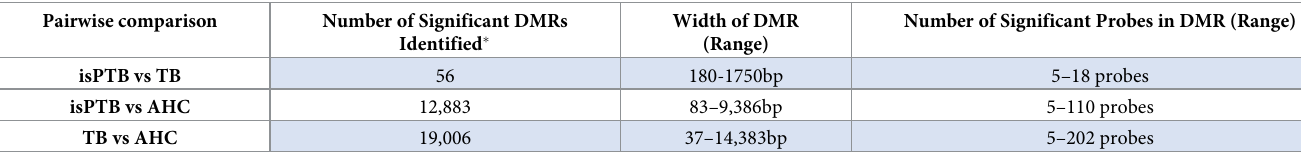
Table 2. Summary of significantly differentiated DMRs identified by DMRcate encompassing both coding and non-coding loci. Width of DMR Number of Significant Probes in DMR (Range) Pairwise comparison Number of Significant DMRs (Range) Identified � isPTB vs TB 56 180-1750bp isPTB vs AHC 12,883 TB vs